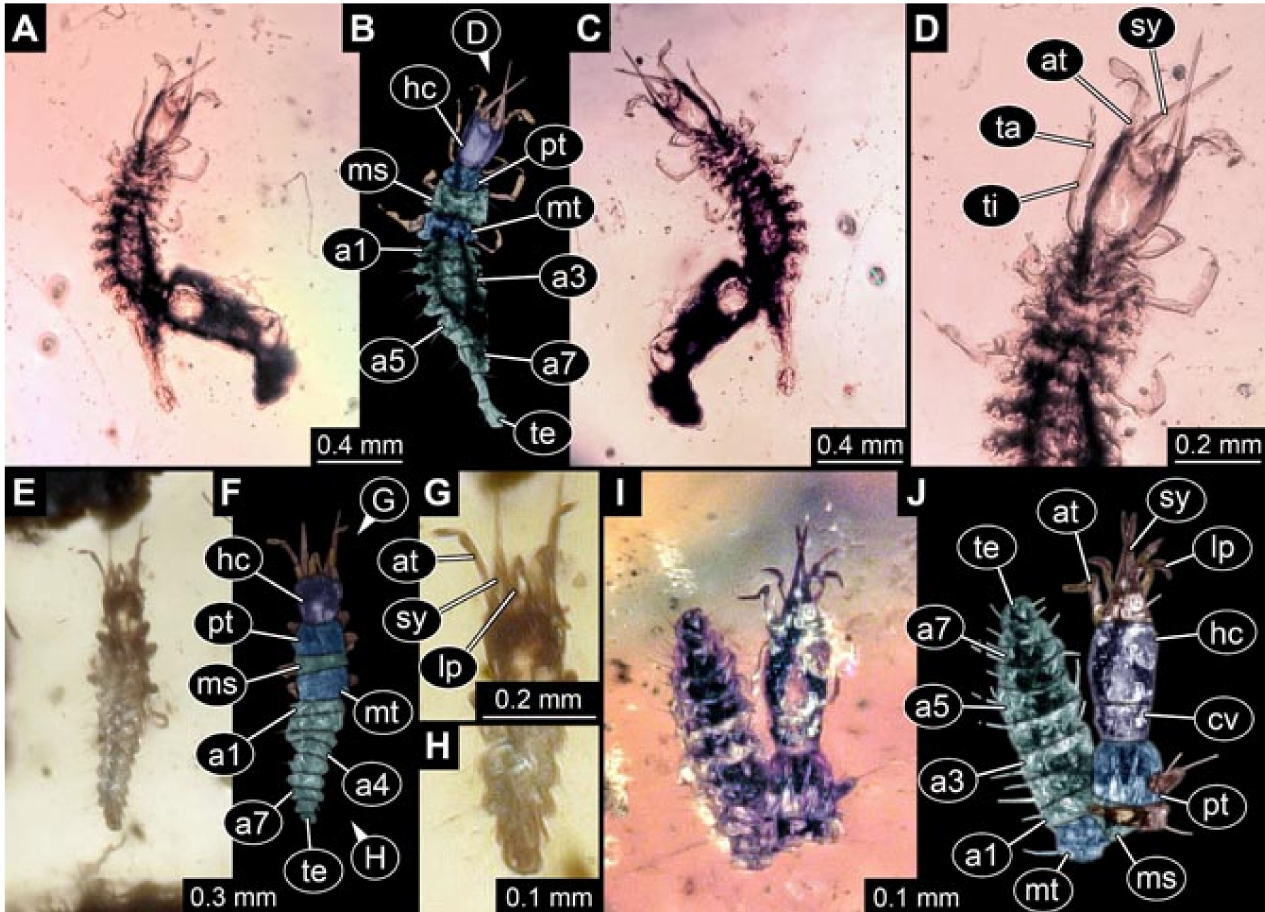
Figure 13. Specimens in Myanmar amber. ( A – D ) Specimen 5834 (PED 0380). ( A ) Dorsal view. ( B ) Dorsal view, colour- marked. ( C ) Ventral view. ( D ) Close-up of head and trunk appendages in dorsal view. ( E – H ) Specimen 5835 (CJW F 3198). ( E ) Dorsal view. ( F ) Dorsal view, colour-marked. ( G ) Close-up of head in dorsal view. ( H ) Close-up of trunk end in dorsal view. ( I – J ) Specimen 5836 (CJW F 3336). ( I ) Dorsal view. ( J ) Dorsal view, colour-marked. Abbreviations: a1–a7 = abdomen segment 1–7; at = antenna; cv = cervix; hc = head capsule; lp = labial palp; ms = mesothorax; mt = metathorax; pt = prothorax; sy = stylet; ta = tarsus; te = trunk end; ti =